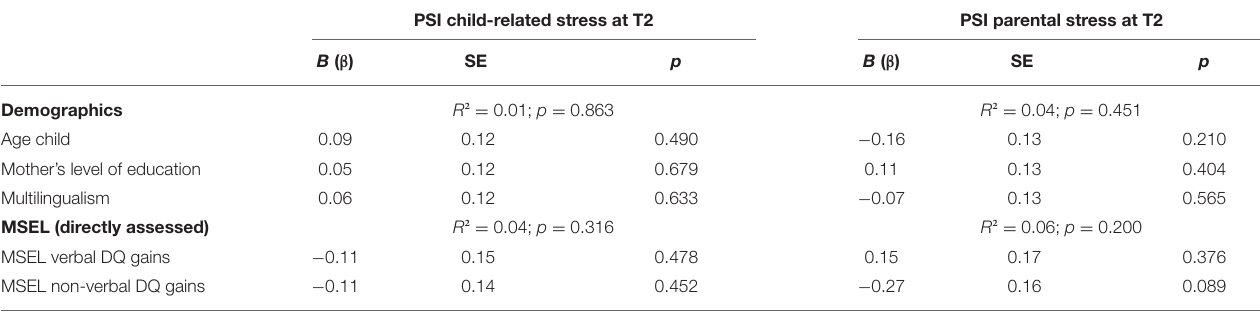
TABLE 3 | Multiple regression analyses using z-standardized (pooled) values of demographic variables and MSEL verbal/non-verbal DQ gains predicting PSI child-related and parental stress at T2.